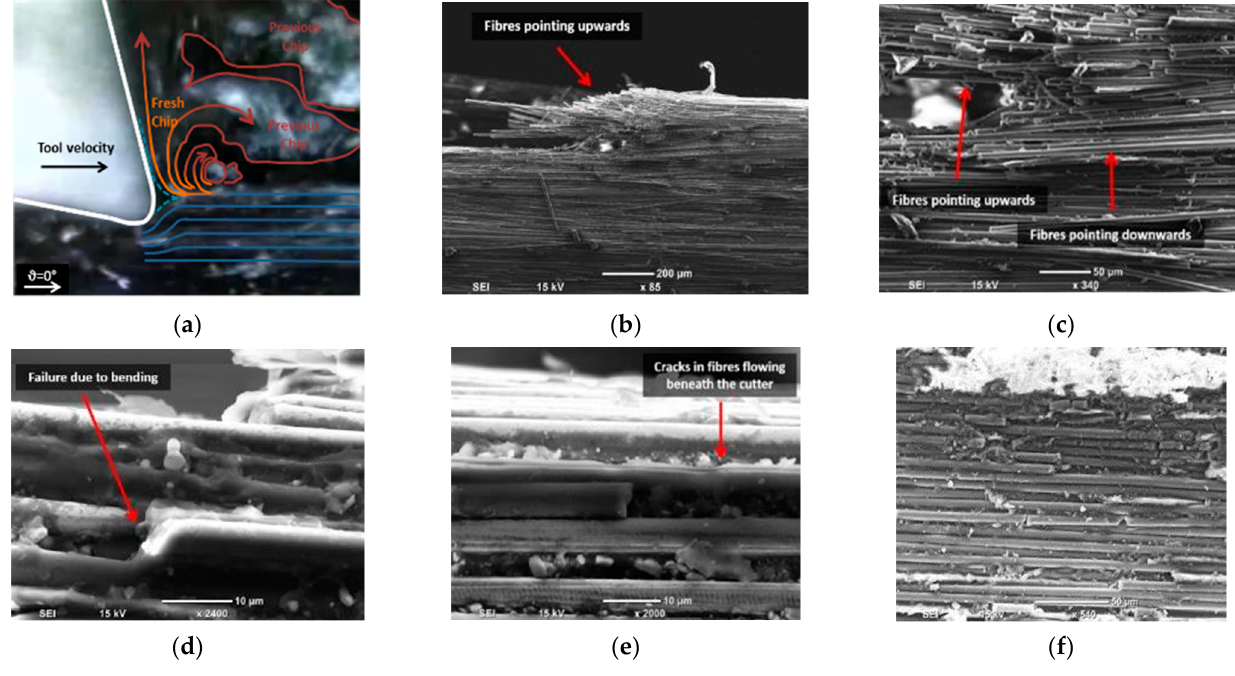
Figure 8. Chip formation at fibre orientation 0° and tool rake angle 10°, ( a ) a schematic overlaid on a digital image; ( b ) The chip root; ( c ) a magnified view of the chip root; ( d ) a side view showing fibre failure; ( e ) a side view revealing fibre crack; and ( f ) a top view of the machined surface.